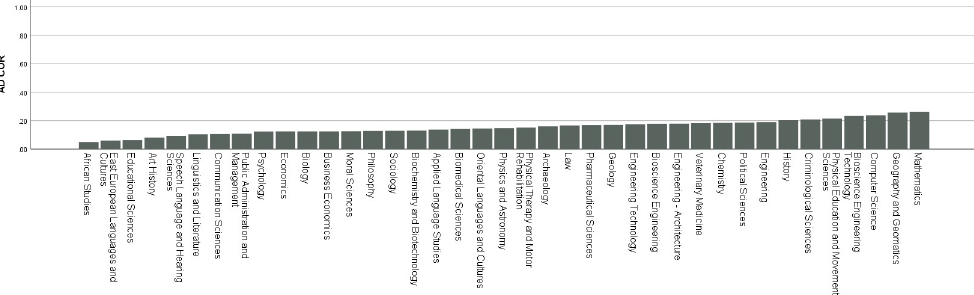
Fig 2. Interest diversity program spread across the 0–1 continuum. The X-axis displays the 39 study programs featuring in this study. Y-axis displays the program interest diversity expressed through an AD COR